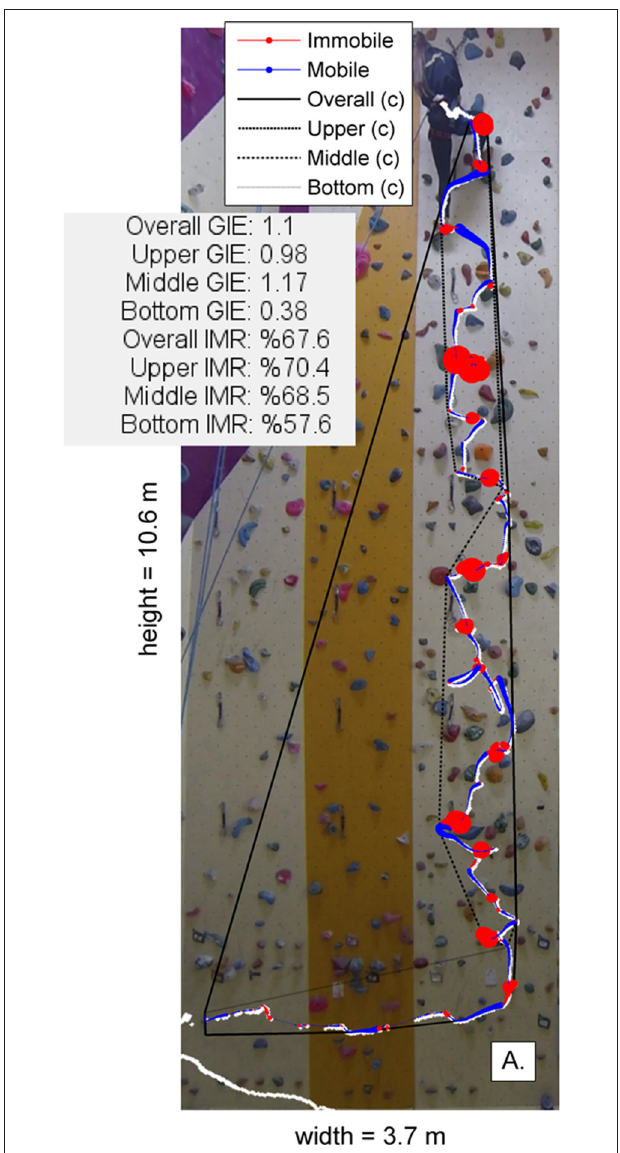
FIGURE 2 | The relationship between entropy and immobility as a function of wall position. Radius of each point was scaled to increase in proportion to the duration spent in a given state (thus the larger the dot, the longer the individual was in the given state of mobility (i.e., blue line) or immobility (redline). c, convex hull. Also note that upper means the top convex hull. Middle means the middle convex hull, bottom means bottom convex hull, and overall means the total convex hull. GIE, geometric index of entropy; IMR, immobility to mobility; m,